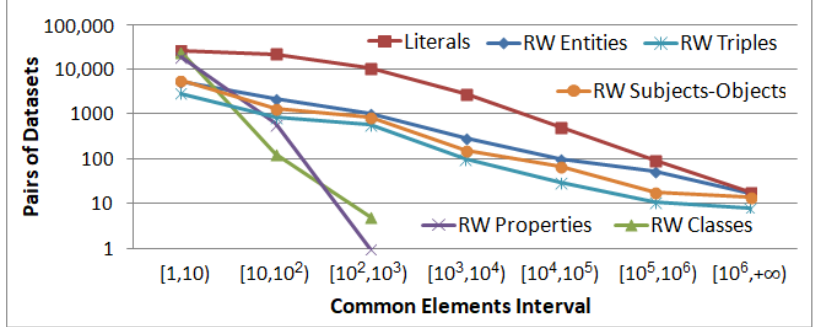
Figure 5. Number of connected pairs of datasets per interval for each measurement